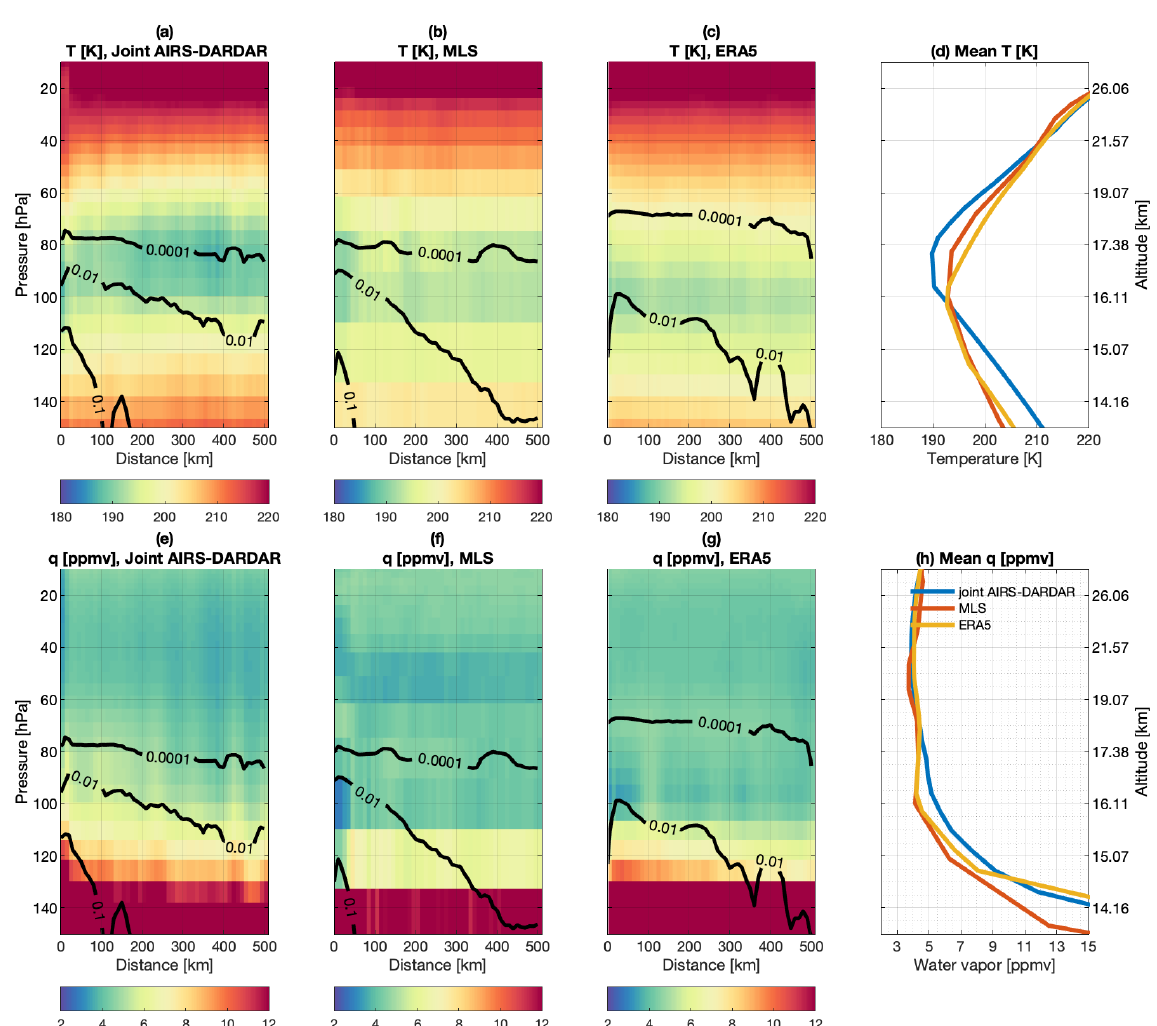
Figure 7. Cyclone-centered composites of temperature (shading, K), water vapor (shading, ppmv), and ice water content (black contour, g/m 3 ). Temperature (a) and water vapor (e) from the joint AIRS–DARDAR retrieval; the sample counts are shown in Fig. 5b. Temperature (b) and water vapor (f) from the MLS v4.2 product; the sample counts are shown in Figs. 1c and 5a. The IWC is from DARDAR-Cloud; the sample density is shown in Fig. 1a. Temperature (c) and water vapor (g) from the ERA5 product sampled at the same locations as in (a, e) . Mean temperature (d) and water vapor (h) profiles from the different